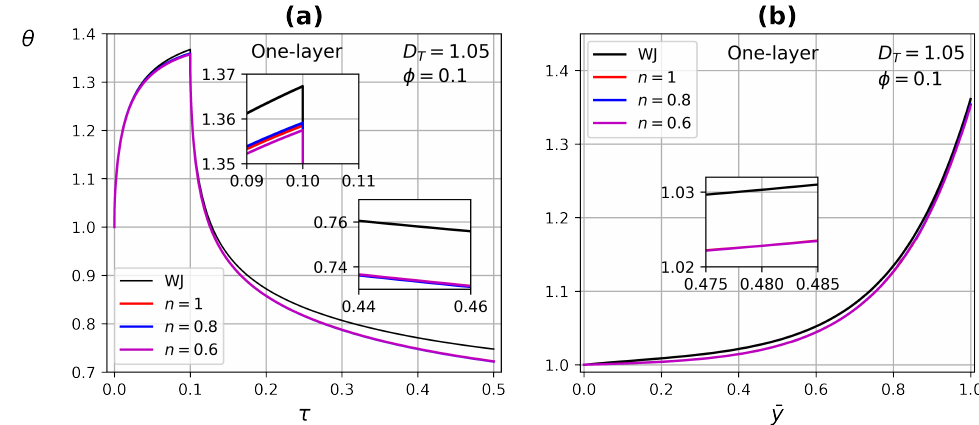
Figure 13. Temperature profiles as a function of ( a ) time and ( b ) tissue layer depth for different power-law index n at τ = 0.09 and porosity φ = 0.1.